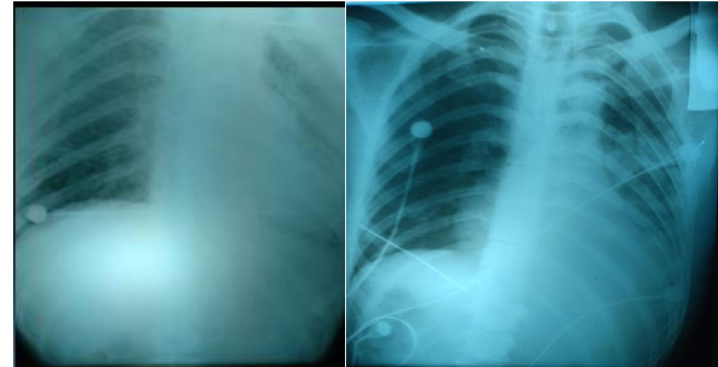
Fig. 2 Left-sided homogenous consolidation opacity with air bronchogram before and after antibiotic